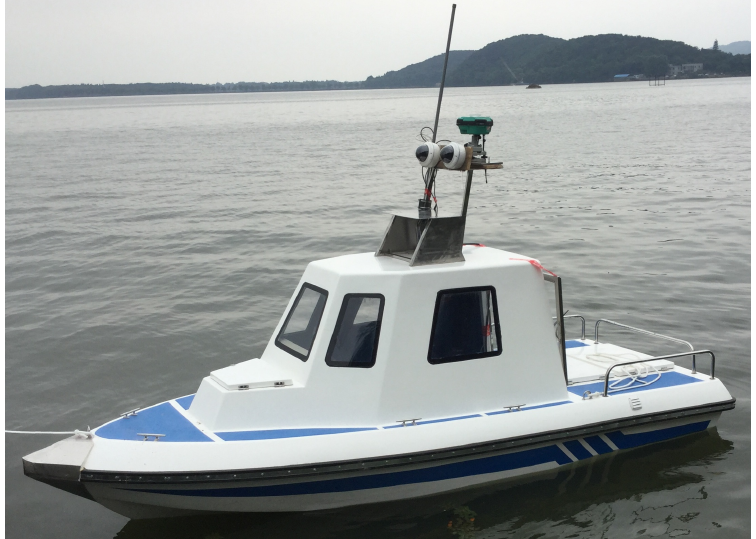
Figure 5. Our inland USV in the